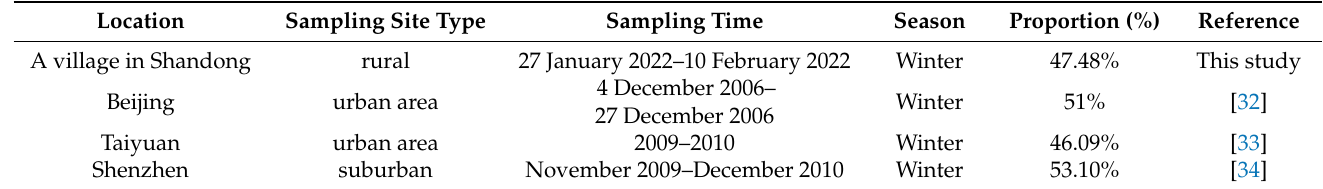
Table 3. The proportion of water-soluble ions in PM 2.5 in some urban and rural areas of